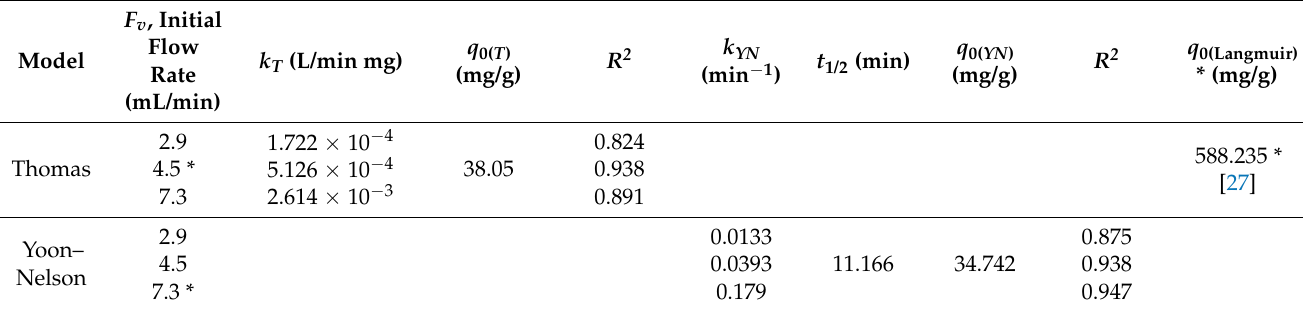
Table 3. Thomas and Yoon–Nelson models applied for BRed dye—residual Bacillus sp . biomass immobilized in an alginate biosorption system in a dynamic